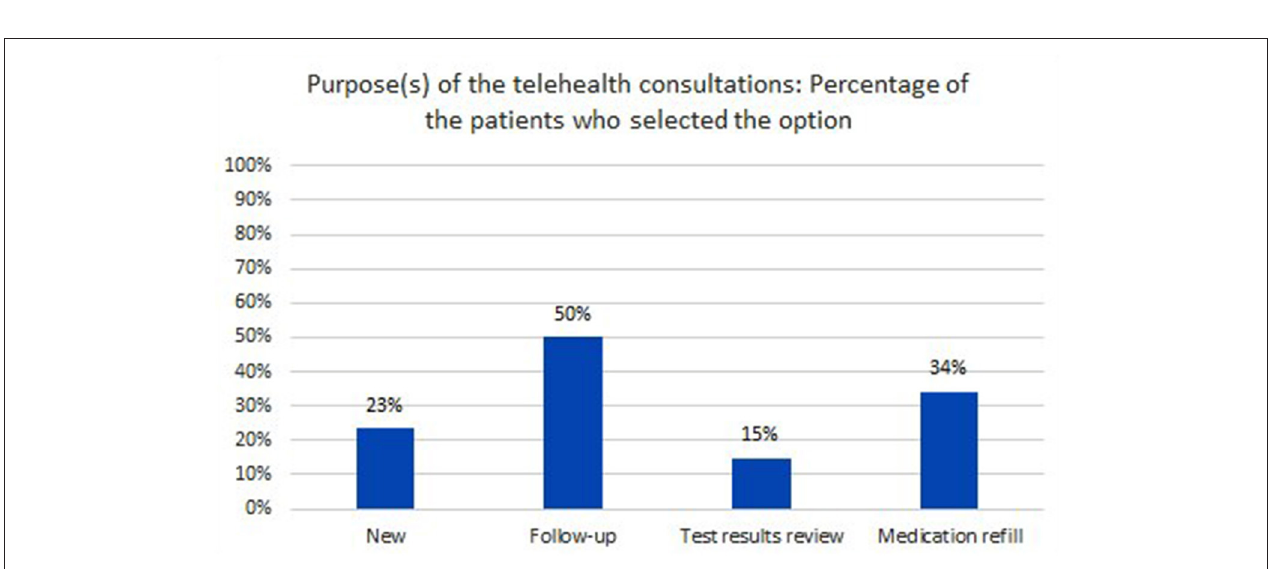
FIGURE 5 | Distribution of patients, based on reason(s) for resorting to telehealth.